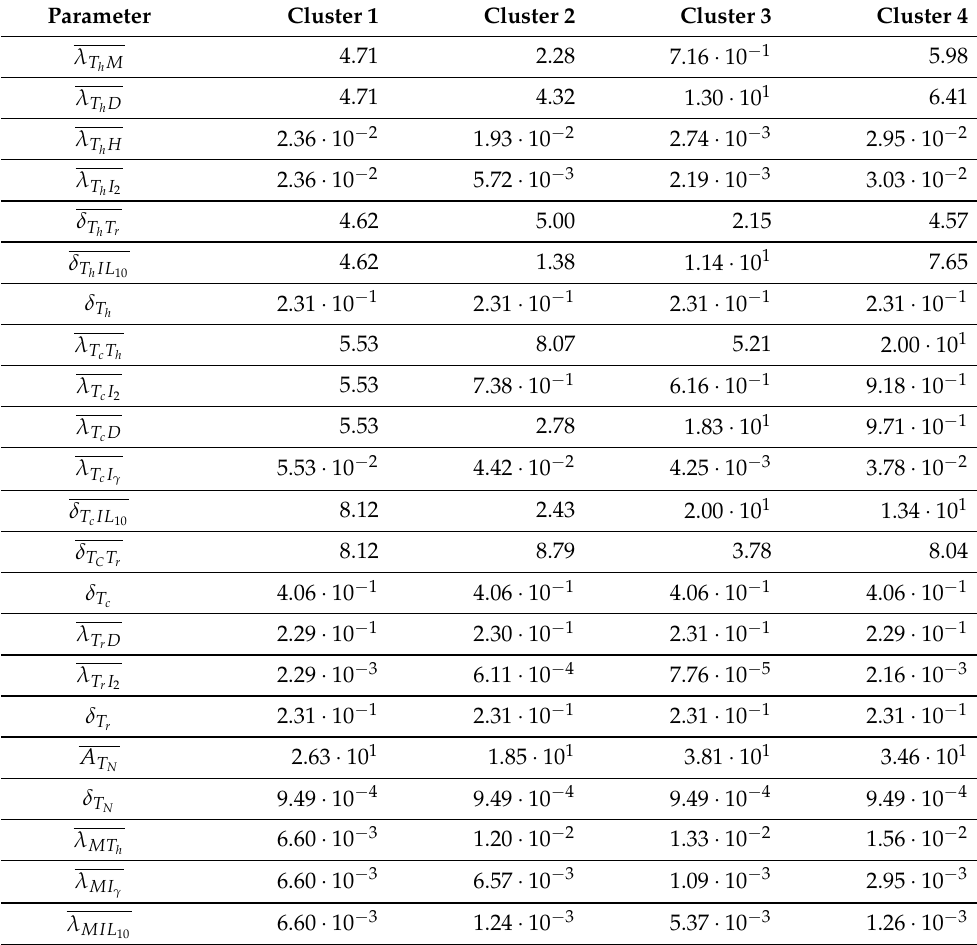
Table A3. Nondimensionalized parameters.